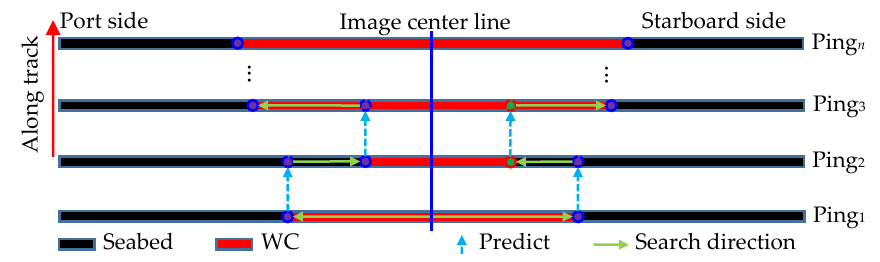
Figure 7. Sea bottom line extraction process.